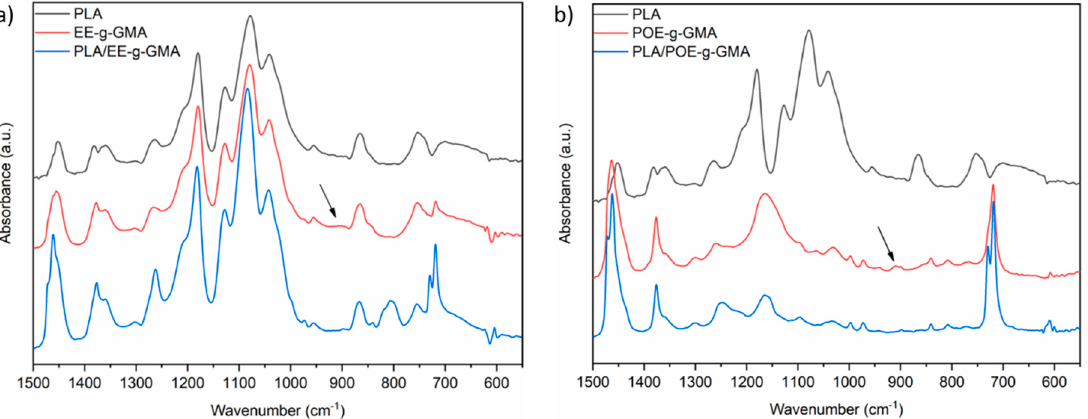
Figure 5. Infrared spectra of pure PLA, ( a ) EE-g-GMA and of the blend PLA/EE-g-GMA and ( b ) POE-g-GMA and of the blend PLA/POE-g-GMA.